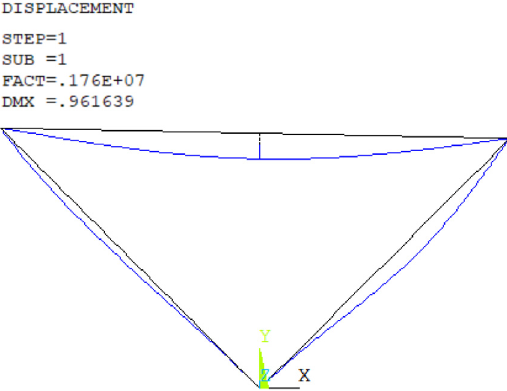
Fig. 4. Buckling results of single-span mechanical model